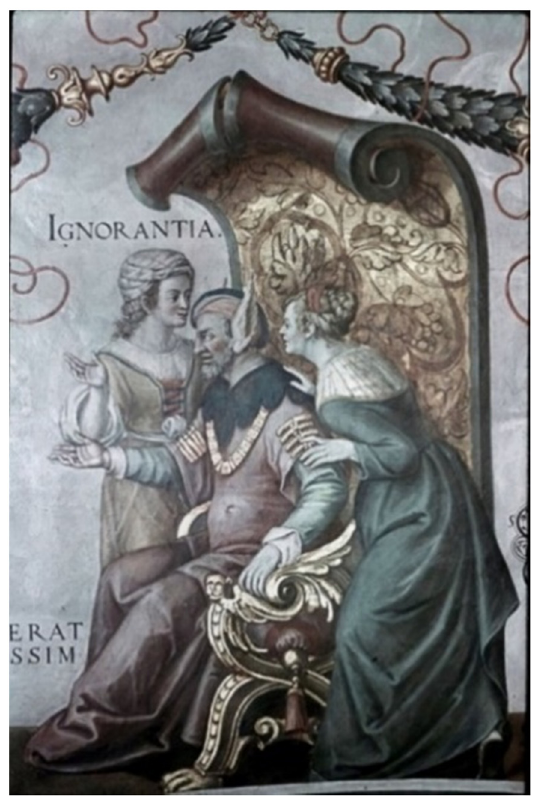
Figure 9: Dürer, Verläumdung ,